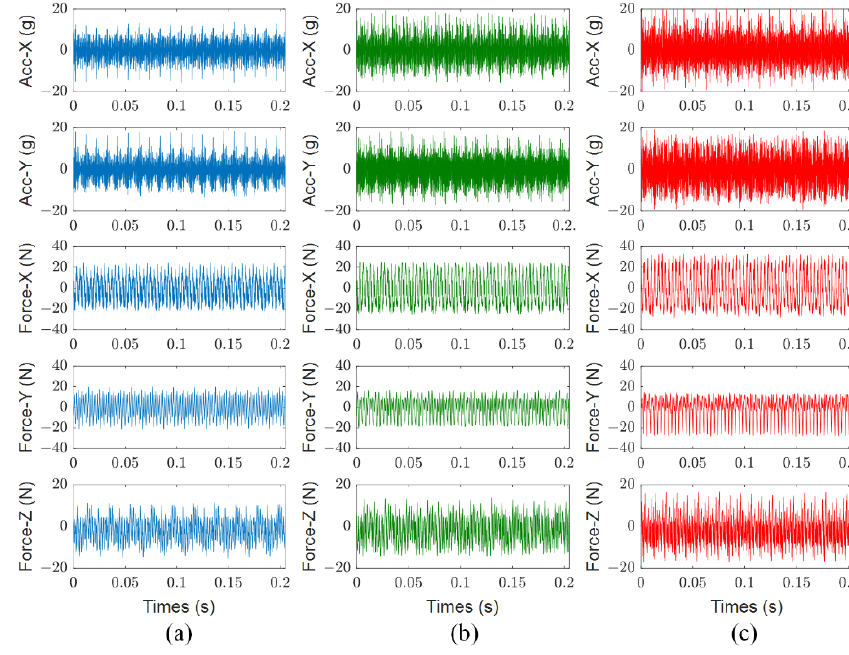
Figure 7. Raw signals of different chatter states. ( a ) Stable; ( b ) Unlabeled; ( c ) Chatter.